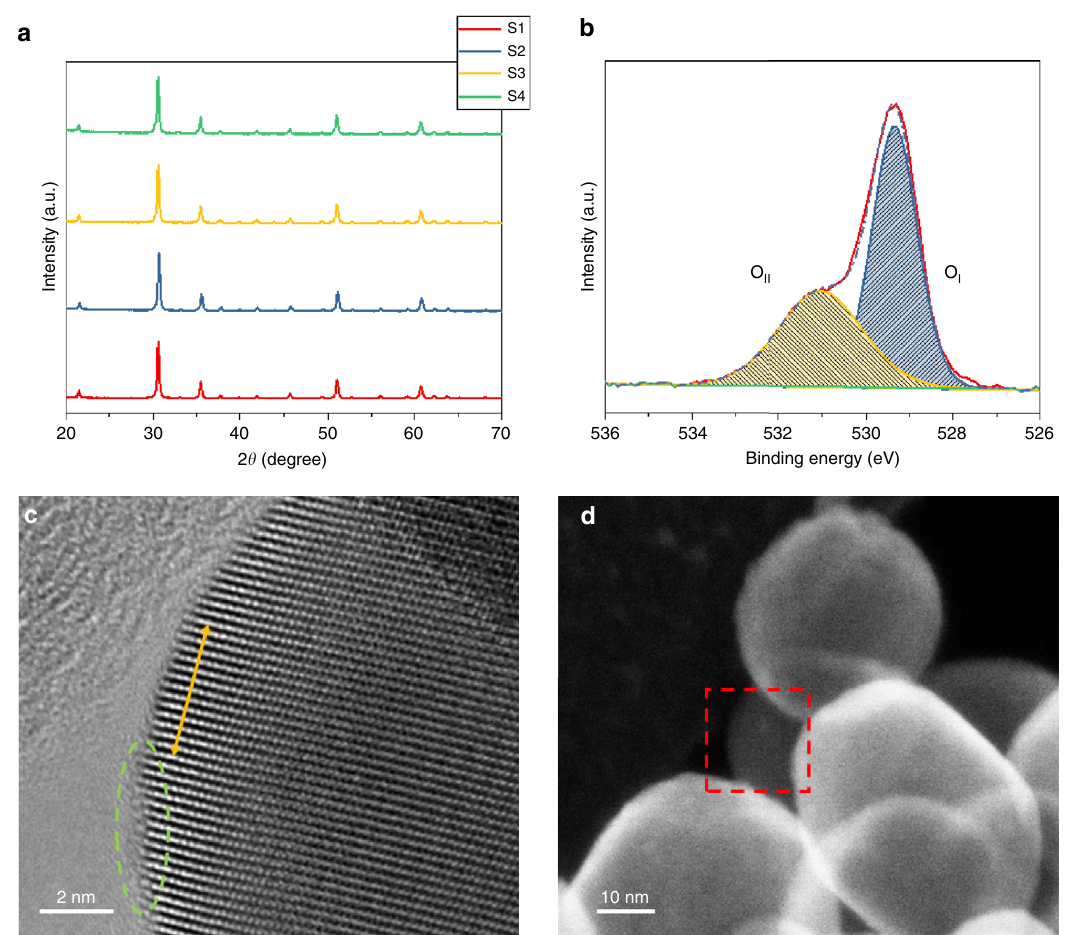
Fig. 1 Structural and morphological information for In 2 O 3 − x /In 2 O 3 materials S1, S2, S3, S4. a PXRD patterns of S1 − S4. b High-resolution O1s core level XPS spectrum of S4. c , d HRTEM and STEM images of S4 at different magni fi cations. A dashed green circle indicates an amorphous phase, yellow arrow indicates the measured lattice spacing and the red square indicates the imaged